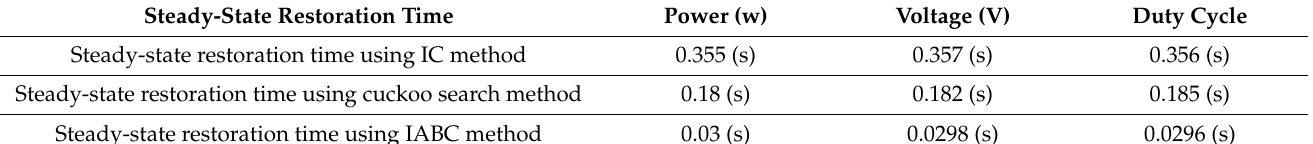
Table 2. Comparison between the incremental conductance method, the cuckoo search method, and the improved artificial bee colony method.